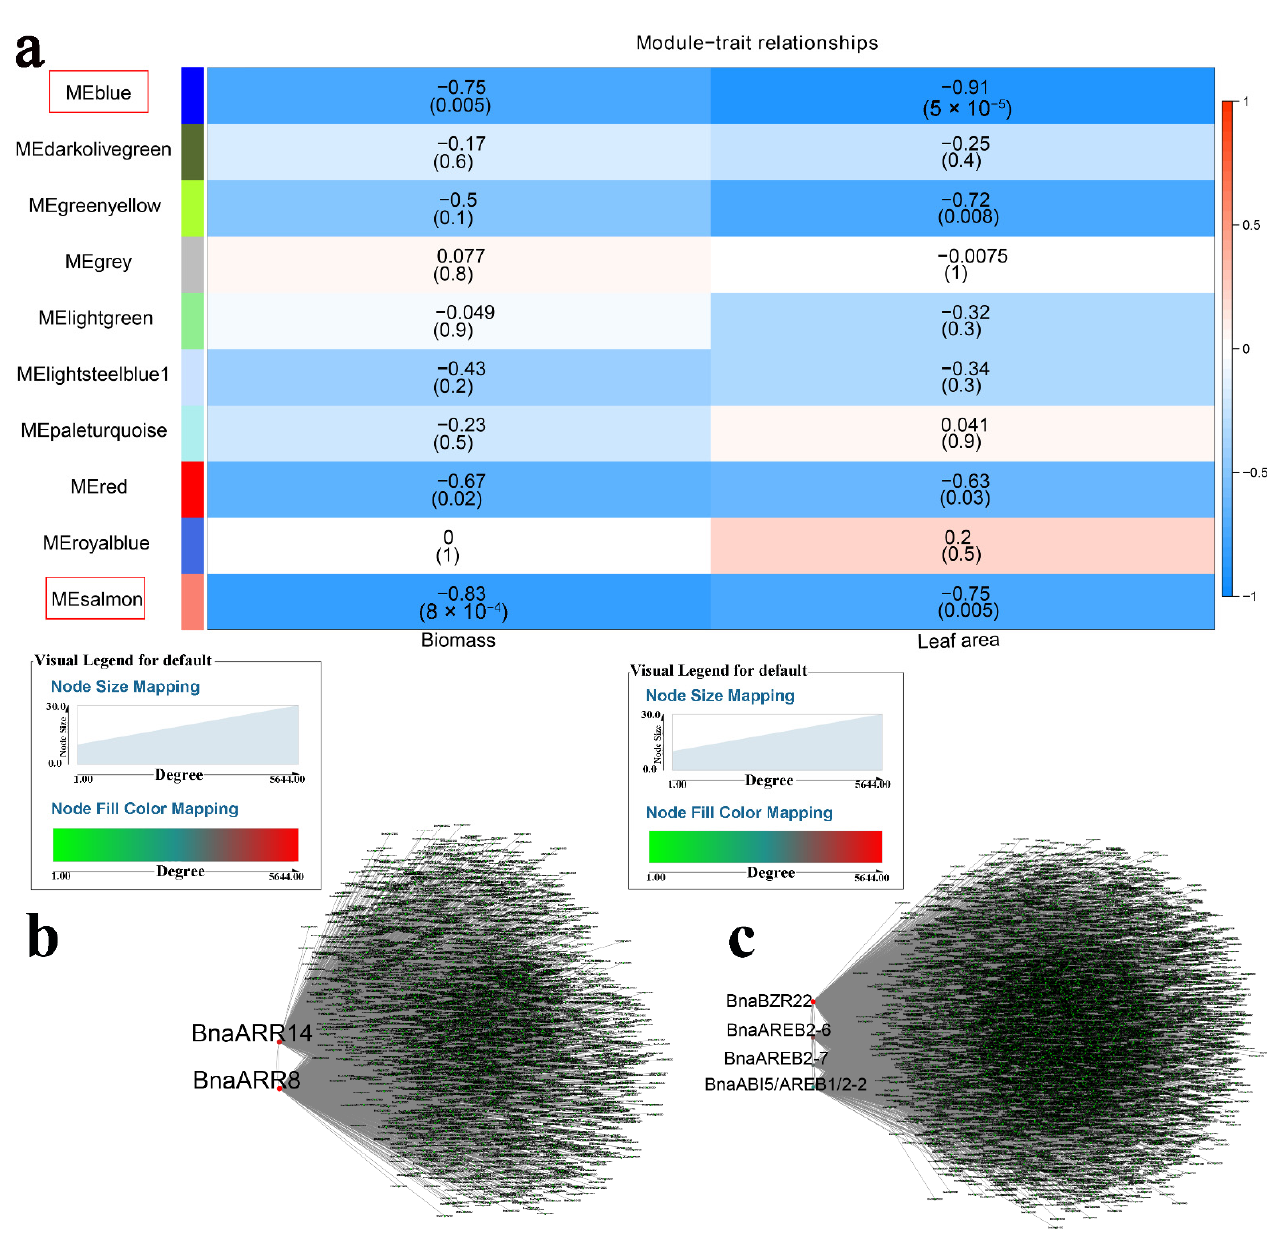
Figure 5. WGCNA of rapeseed genes in response to salt. ( a ) Module-trait correlation showing the significance of module eigengene correlation with traits (biomass and leaf area). Left panel shows modules. ( b ) Cytoscape representation of the relationship of hormone-related TFs in “salmon” mod- ule. Key genes are represented by large red circles. ( c ) Cytoscape representation of the relationship of hormone-related TFs in “blue” module. Key genes are represented by large red circles.